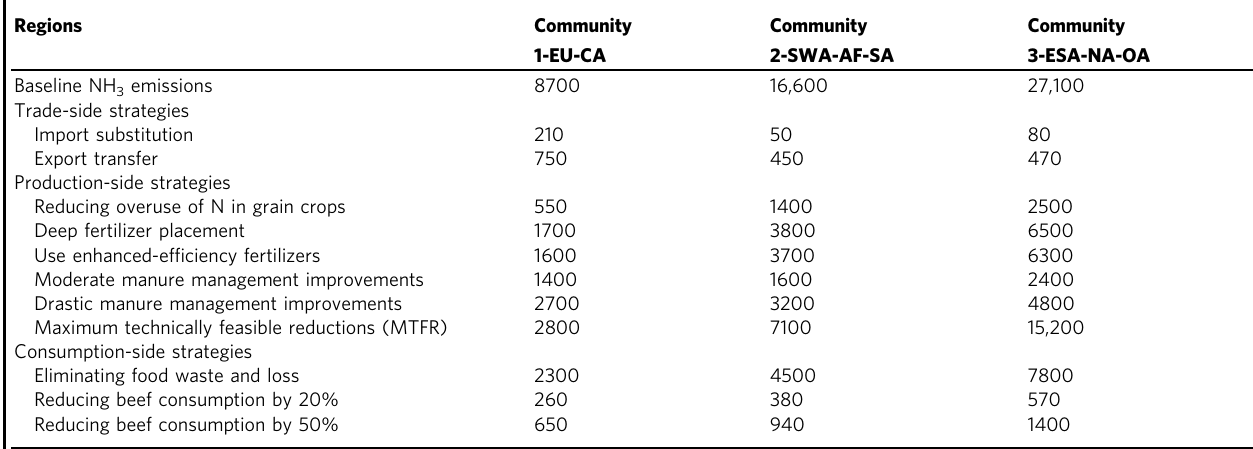
Table 1 NH 3 emissions reductions (unit: Gg) achieved through trade-side, consumption-side, and production-side strategies for the three